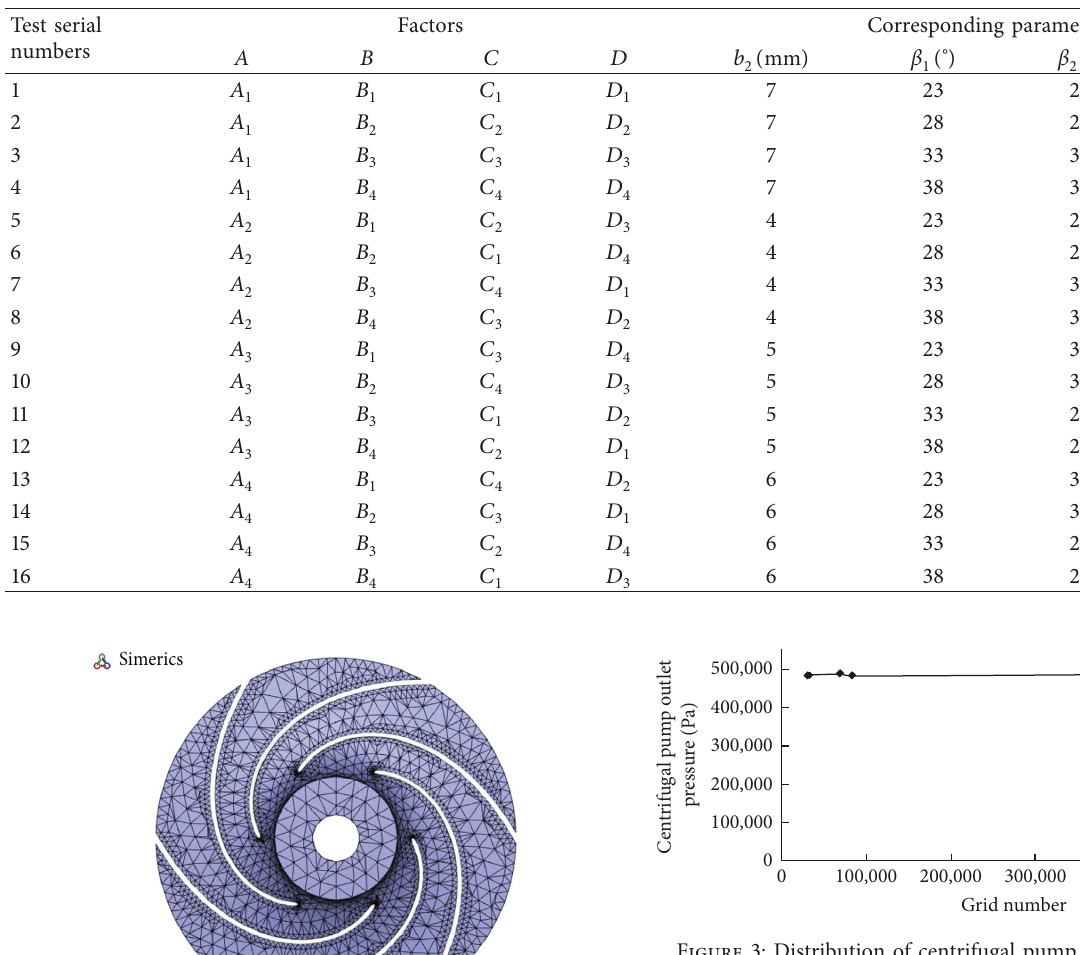
Table 3: Orthogonal test schemes.